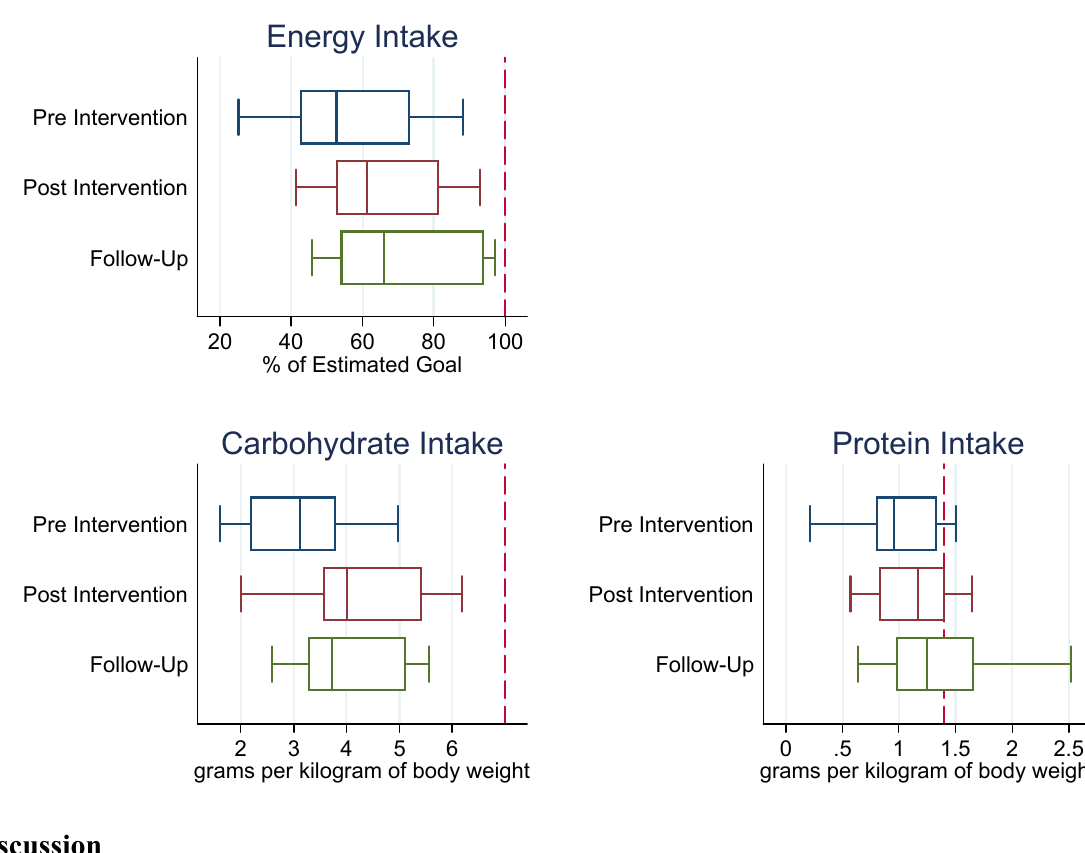
Figure 1. Nutritional intakes at Pre, Post Intervention and at Follow-Up ( N = 11). Notes: Box plots represent medians, the 25th percentile, and the 75th percentile. Whisker plots represent lower and upper adjacent values. The dashed line represents the (estimated) nutritional